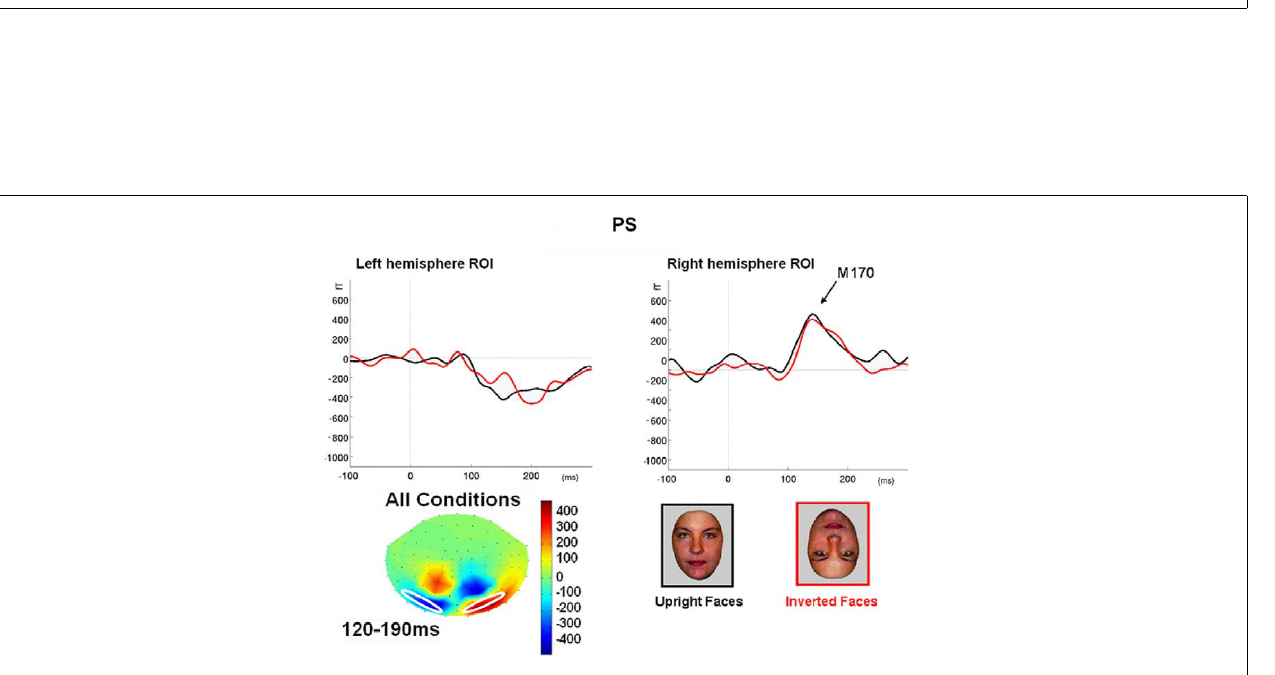
FIGUREA9 | Evolution of magnetic fields evoked by visual stimulation as calculated from the root-mean-square (RMS) of signals recorded by each of the two orthogonal planar gradiometers at the 102 locations for patient PS averaged across 10ms time windows around the M170